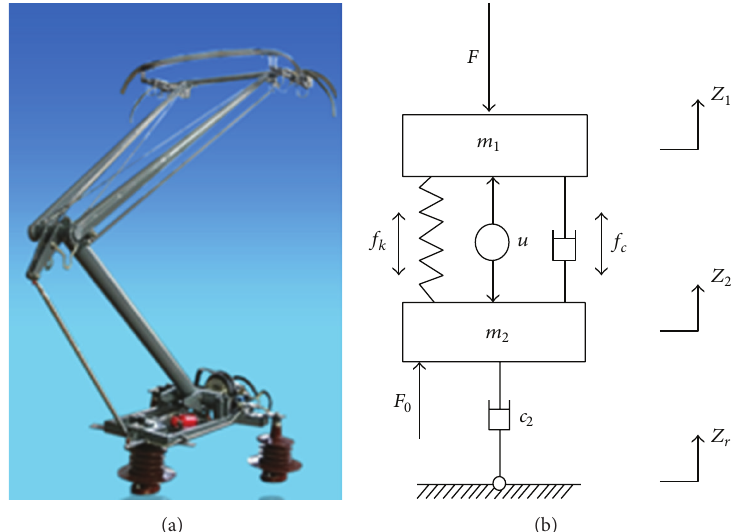
Figure 1: (a) DSA250 produced by CED Railway Electric Tech. Co. (b) A simplified dual-mass pantograph model.